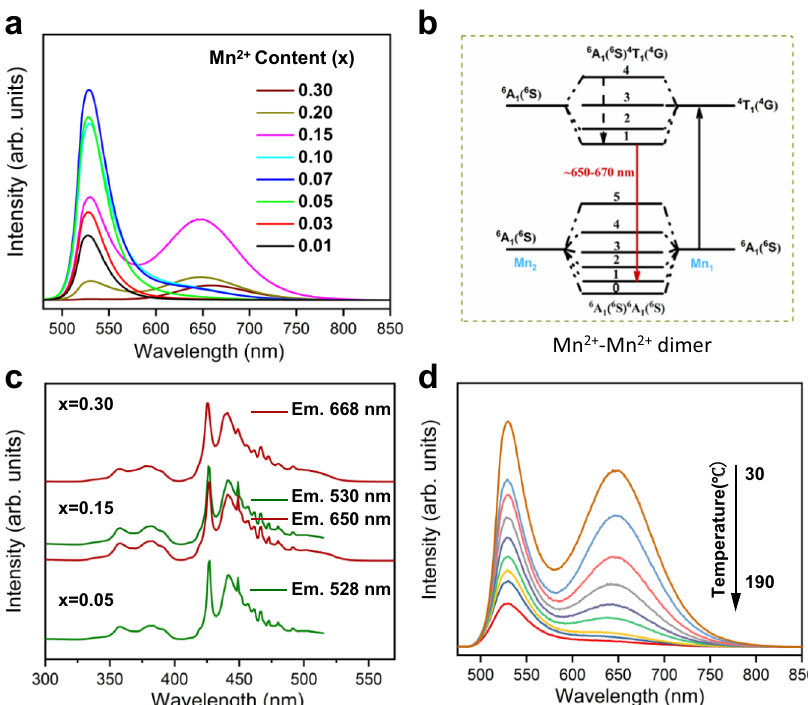
Fig. 3 Photoluminescence properties and the mechanism of Li 2 ZnSiO 4 :Mn 2 + . a Emission spectra of Li 2 Zn 1 – x SiO 4 : x Mn 2 + ( x = 0.01 – 0.30) and b excitation spectra of some typical Li 2 Zn 1 – x SiO 4 : x Mn 2 + ( x = 0.05, 0.15, 0.30) samples. c Schematic diagram of Mn 2 + -Mn 2 + dimer. d Temperature-dependent emission spectra of Li 2 Zn 0.85 SiO 4 :0.15Mn 2 + upon 427 nm blue-light